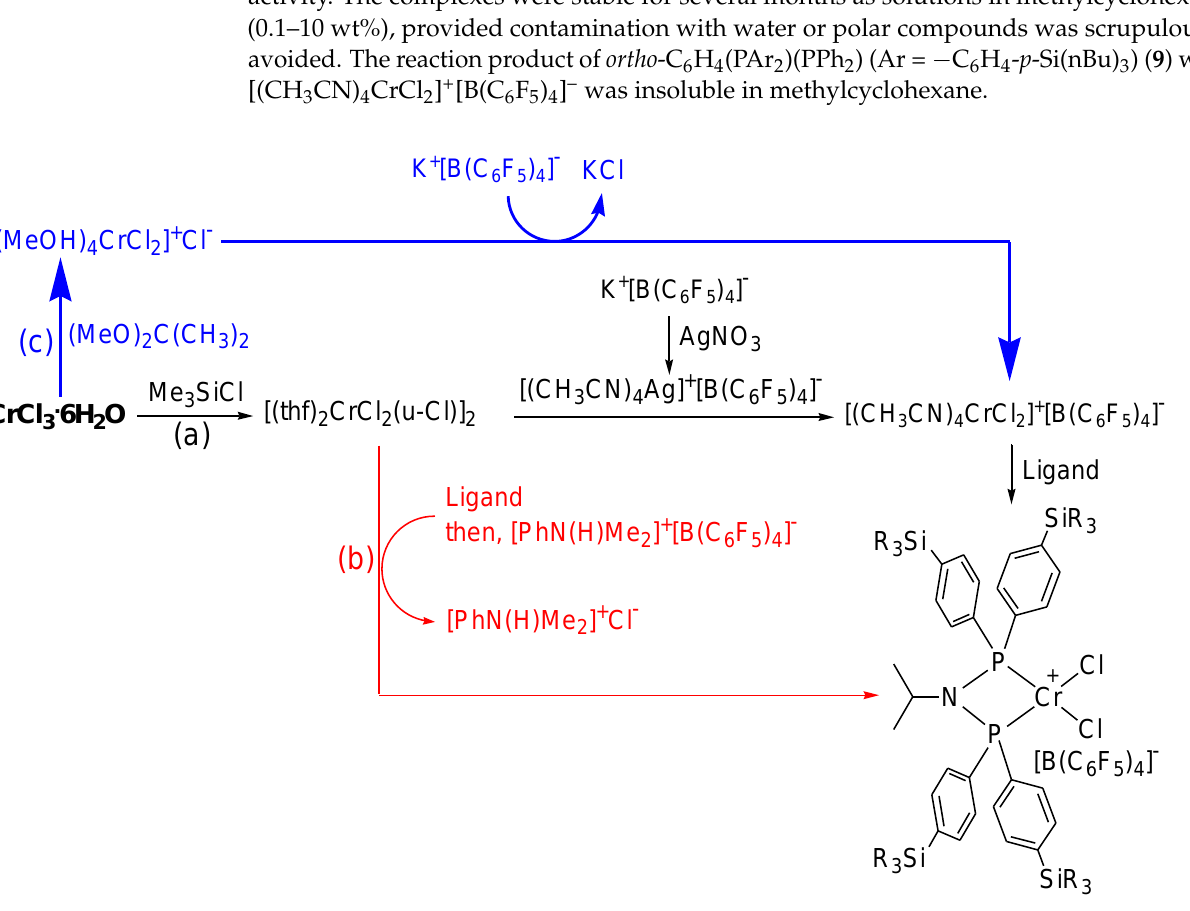
Scheme 3. Synthetic routes for [iPrN(PAr 2 ) 2 CrCl 2 ] + [B(C 6 F 5 ) 4 ] − (Ar = −C 6 H 4 - p -SiR 3 ) ( a , original route; b and c , simplified routes in this work).